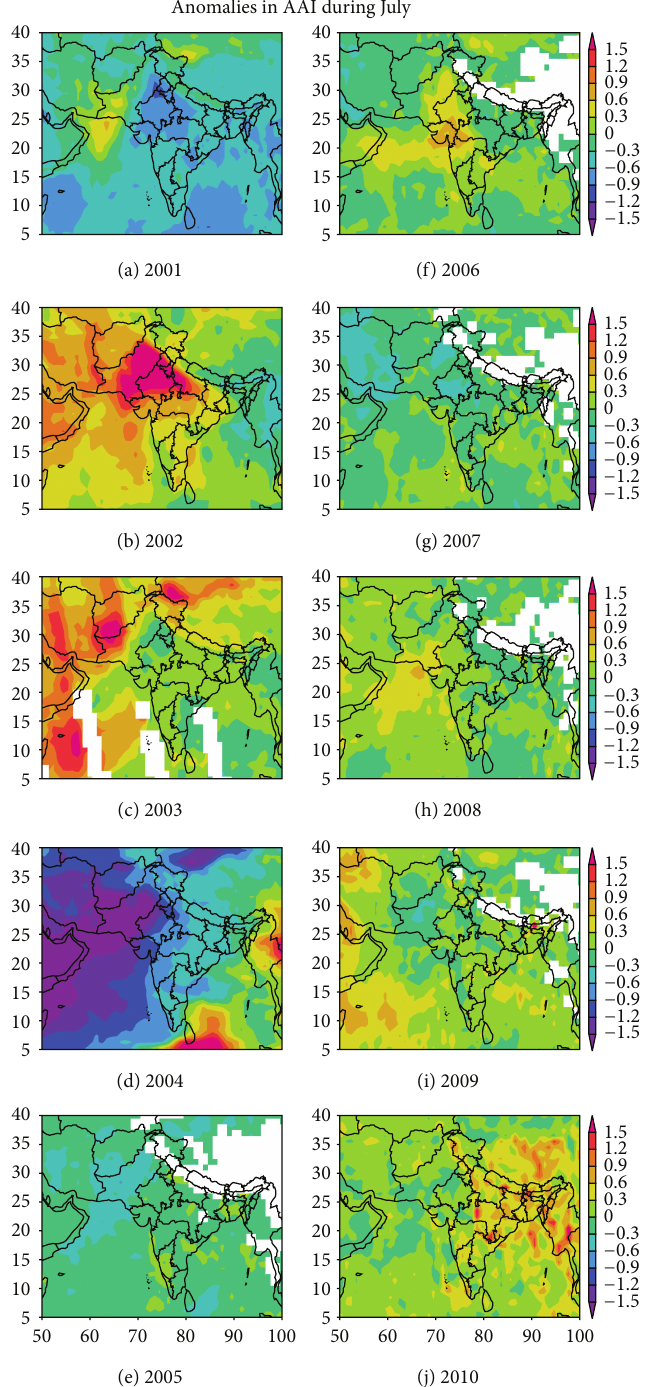
Figure 7: Absorbing aerosol index (AAI) anomalies over the Arabian Sea, India, and the Bay of Bengal during July in (a) 2001, (b) 2002, (c) 2003, (d) 2004, (e) 2005, (f) 2006, (g) 2007, (h) 2008, (i) 2009, and (j) 2010. anomalies during July and JJAS, 2010, while no such features are seen in AODs. These interannual variations could lead to lower values of